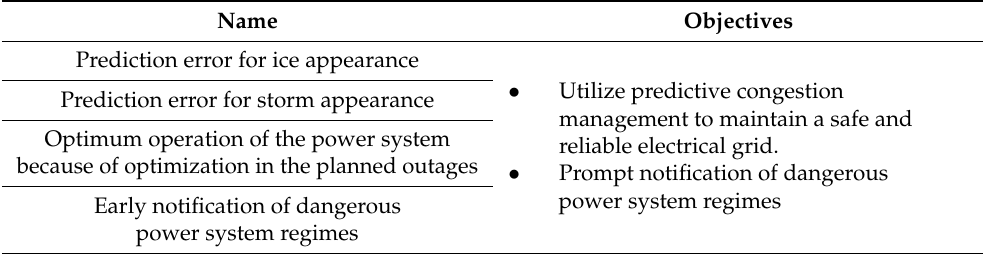
Table 2. Key performance indicators for the BUC.